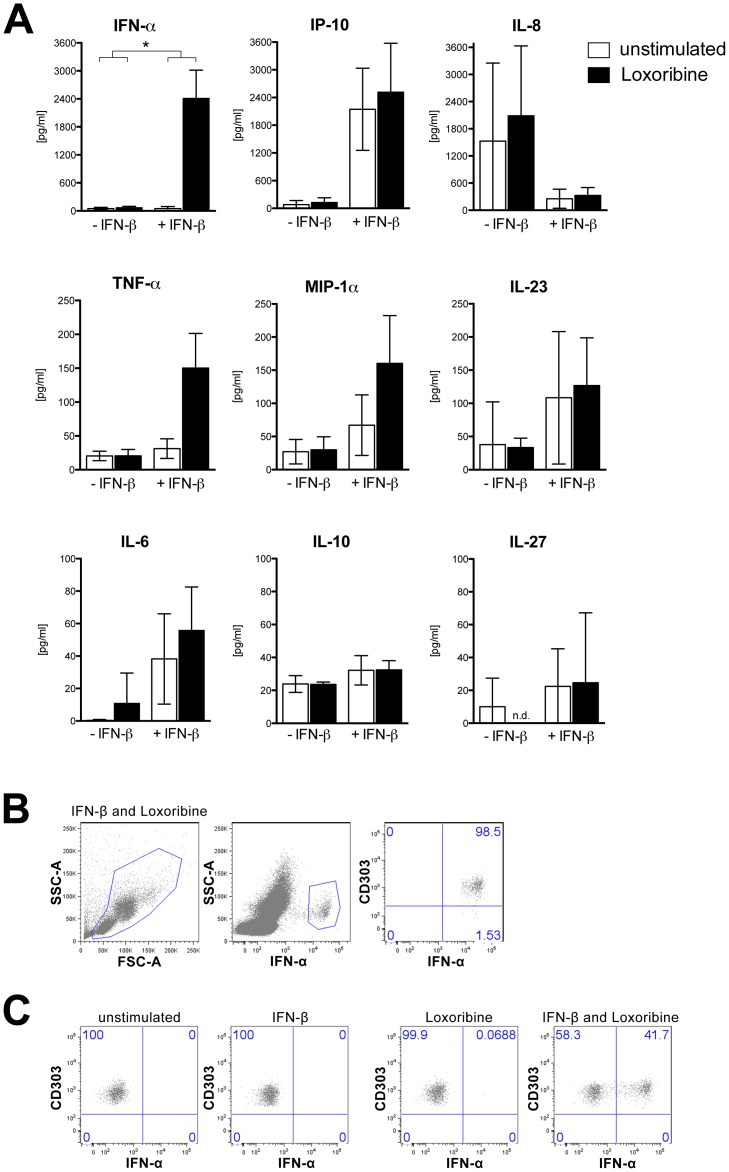
Interferon-β pre-treatment leads to strongly increased production of interferon-α upon TLR7 stimulation.(A) PBMCs from healthy donors were either incubated with 1000 U/ml interferon-β or left untreated for 12 hours. Subsequently, TLR7 was stimulated with 0,1 mM loxoribine for additional 6 hours. Amounts of cytokines and chemokines were determined in cell culture supernatants by bead-based immunoassays. Results shown are mean±SD from n = 3 healthy donors. For assessment of statistical significance, the values of loxoribine-untreated cells were subtracted from values of loxoribine-treated cells for both, cells with and without interferon-β pre-treatment, and the resulting differences compared by paired t-test. * p<0,05. (B, C) Cells were treated as in (A), but brefeldin A was added for the final 3 hours of stimulation before the intracellular expression of interferon-α was analyzed by flow cytometry. Representative dot plots showing (B) the percentage of CD303+ cells (pDCs) of all interferon-α positive cells and (C) the percentage of pDCs positive for interferon-α for one donor representative of n = 4. IFN-α, interferon-α; TNF-α, tumor necrosis factor-α; IFN-β, interferon-β; MIP-1α, macrophage inflammatory protein-1α, IP-10, interferon-γ-induced protein 10; IL, interleukin, n.d., not detected.